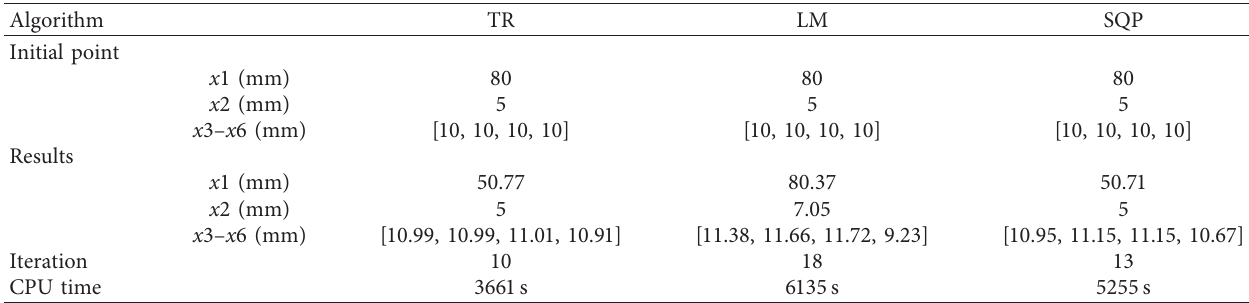
Table 6: Corresponding design variables for each